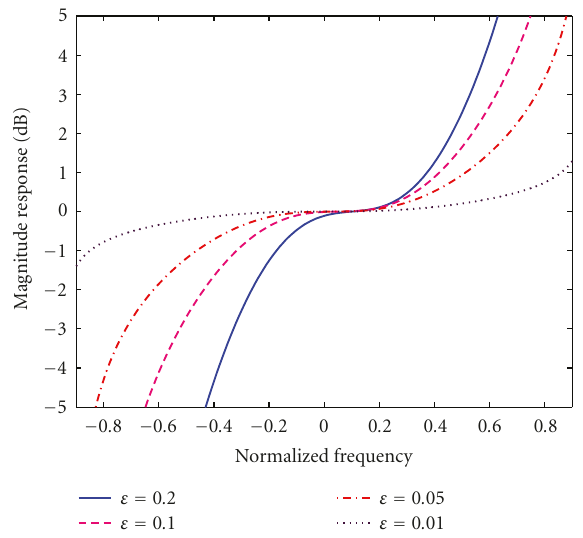
Figure 2: Subchannel frequency response distortion due to CFO for normalized frequency o ff sets ε = 0.01, 0.05, 0.1, and